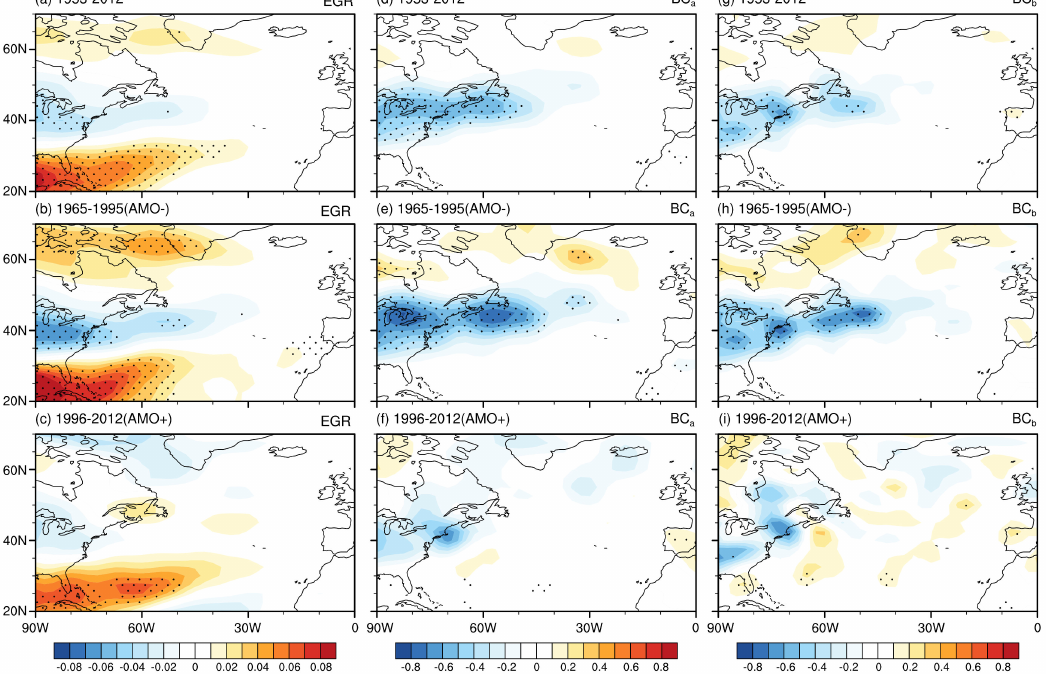
Figure 7. Regression coefficients of the maximum Eady growth rate (shading; units: day − 1 ) at 700 hPa onto the Niño3.4 index in spring during: ( a ) 1953–2012; ( b ) 1965–1995 (AMO − ); and ( c ) 1996–2012 (AMO+). The same as ( a – c ), except for BC (W/m 2 ): ( d – f ) from MAPE to EAPE (BC a ); and ( g – i ) from EAPE to EKE (BC b ). Stippling represents significance exceeding the 95% confidence